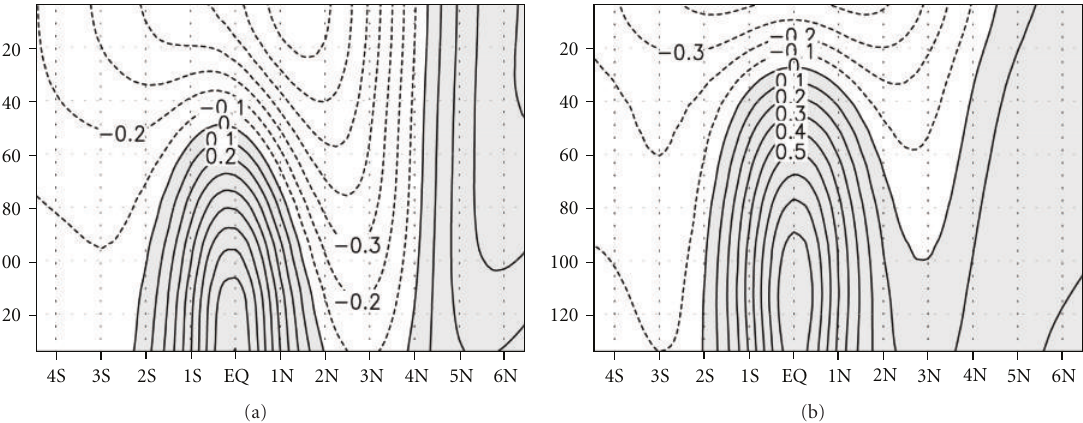
Figure 7: Vertical section of zonal-mean zonal currents averaged (a) from June to September and (b) from March to April, showing the westward SEC (negative contour) and eastward EUC and NECC (positive contour). Units are m/s. Positive values are